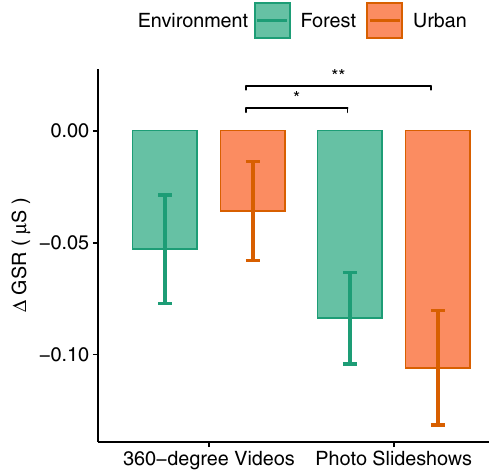
Figure 6. GSR difference scores.